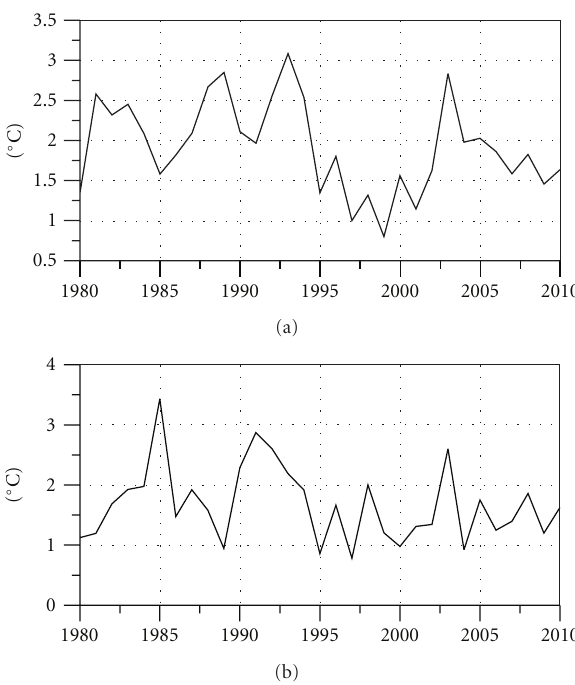
Figure 11: Sensible heat flux at the ocean ice/air interface in winter around Franz Joseph Land (a) and north of Svalbard